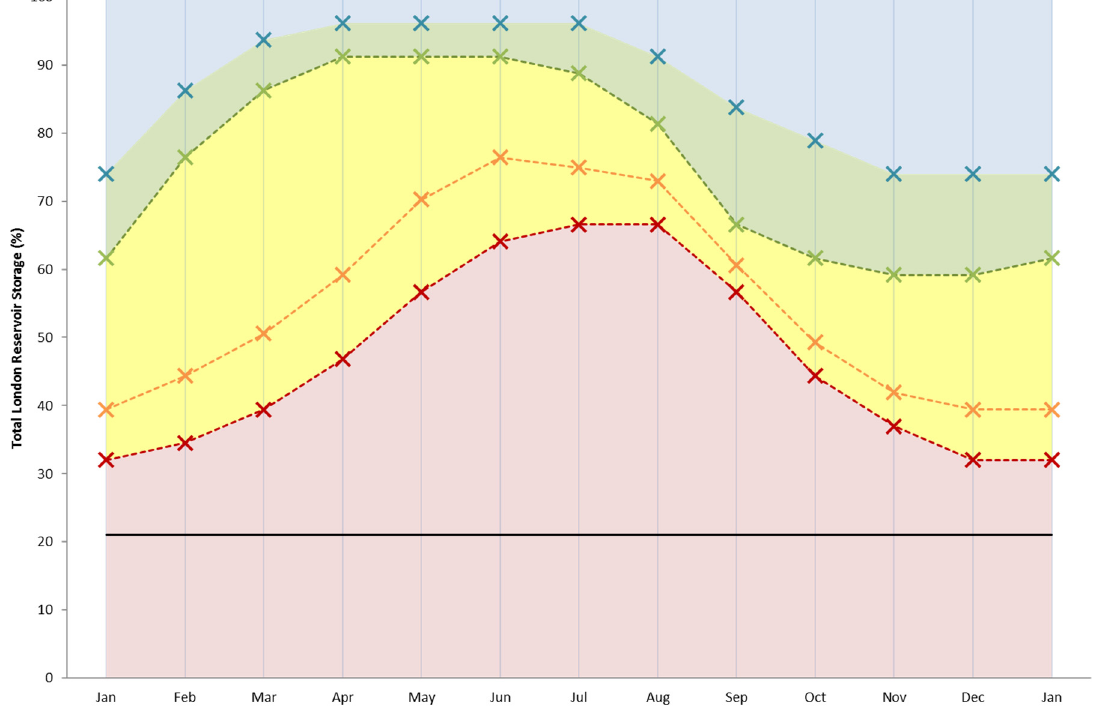
Figure 2. Annotated LTCD showing the 48 decision variables needed to define its shape.